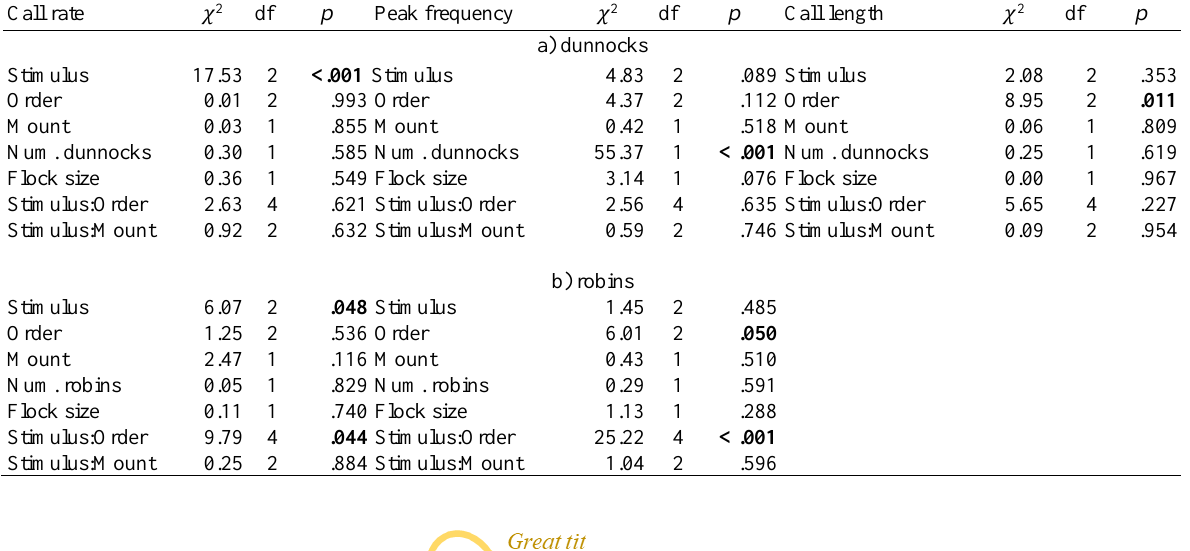
Model Summary for Linear Mixed Models Testing for Predator Type on ways of Encoding Information about Predator Threat for a) Dunnocks, and b) Robins